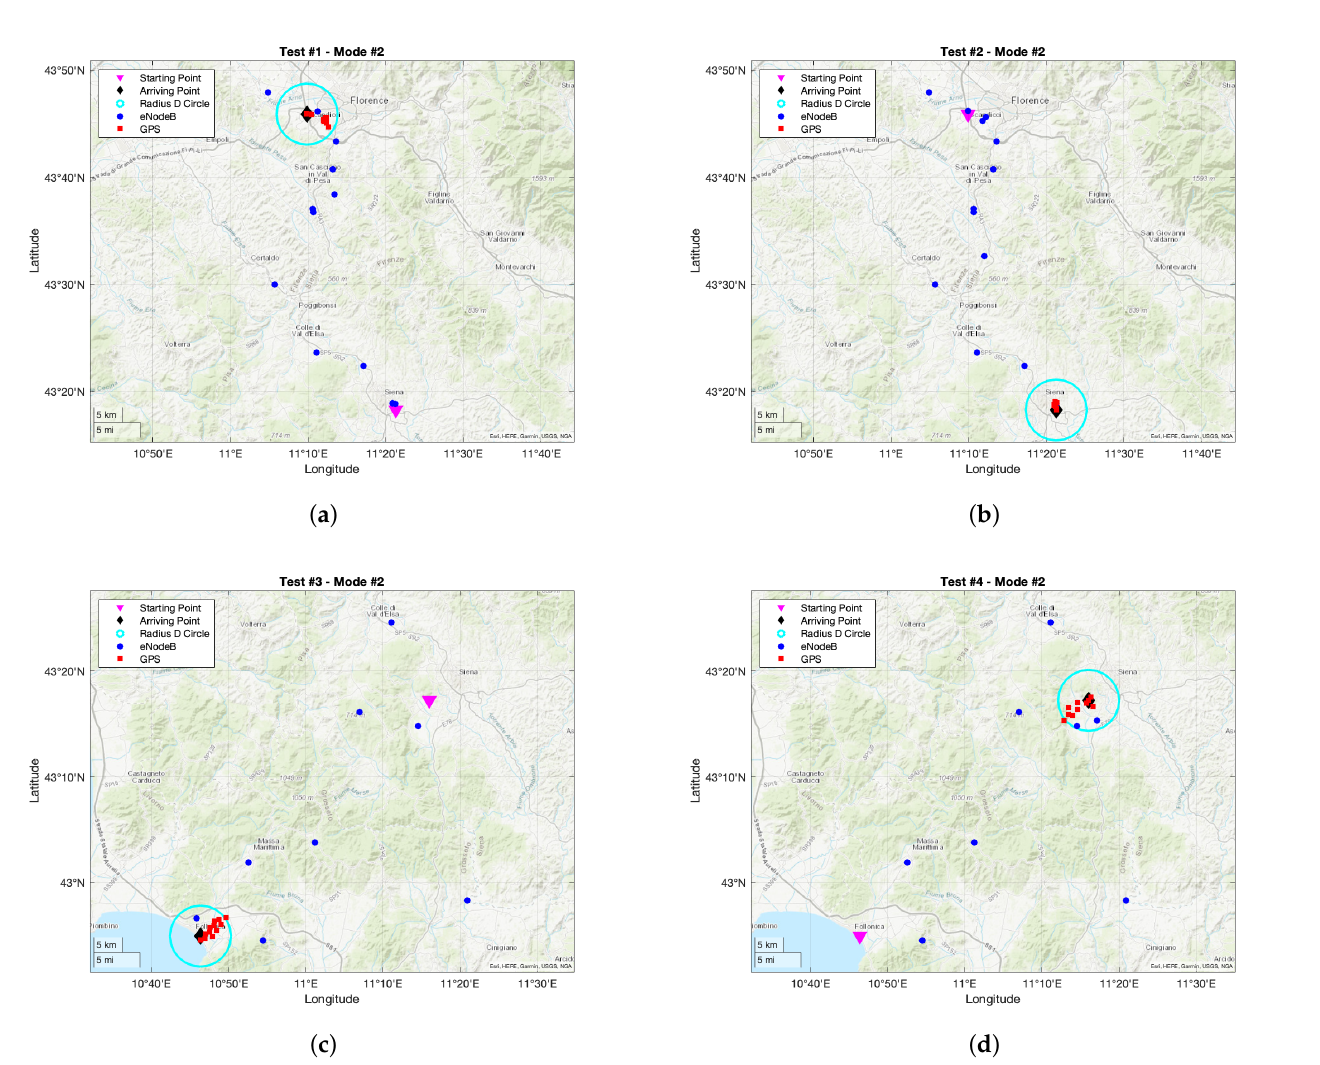
Figure 9. Tracking tests results exploiting working Mode #2: ( a ) outward trip of itinerary of Figure 6a; ( b ) return trip of itinerary of Figure 6a; ( c ) outward trip of itinerary of Figure 6b; ( d ) return trip of itinerary of Figure